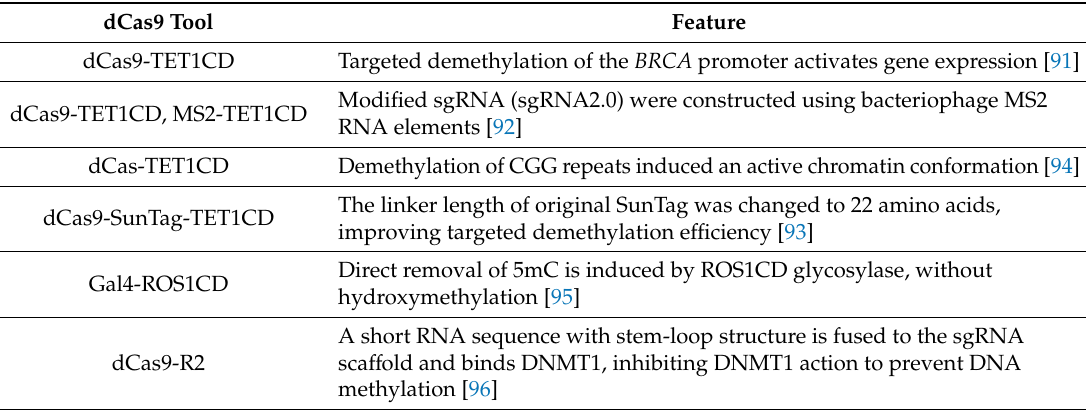
Table 3. Summary of CRISPR-dCas9-based tools for DNA